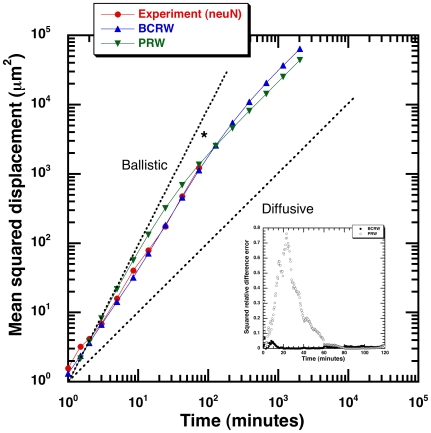
Super-diffusive behavior in mean-squared displacement trends.Simulated mean-squared displacement versus time from a simulation based on BCRW model (blue) compared to the experimental neuN data (red). The bimodal correlation contributes to prolonged super-diffusivity (high persistence) observed in epithelial cells under consideration (neuN cell type). The “*” indicates transition to the diffusive regime in the BCRW model. A fit of the experimental data using a PRW model (green) has been overlaid. Inset: Comparison of BCRW and PRW model predictions with the experimental mean-squared displacement. The squared relative difference error (difference normalized using the experimental mean-squared displacement at a given time) for predictions from BCRW and PRW model. The BCRW model predictions are in good agreement with the experiments.